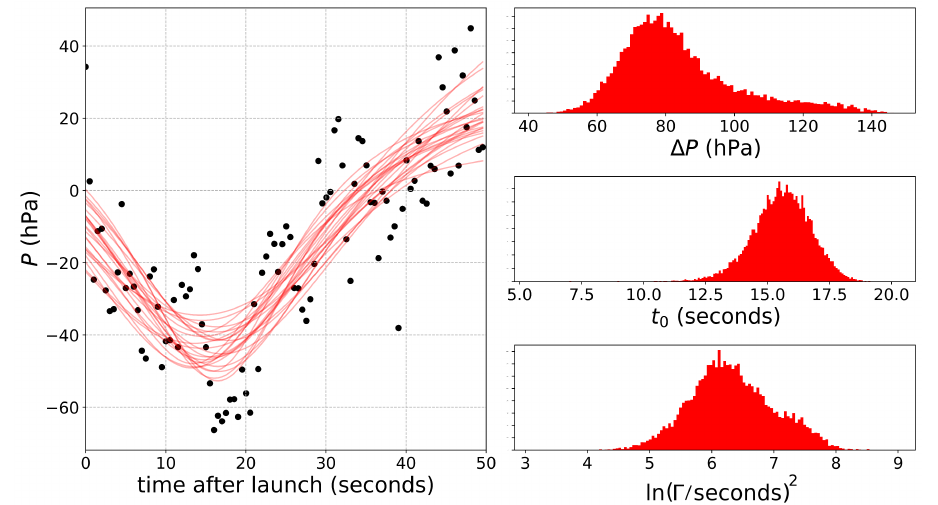
Figure 11. The left panel shows the Lorentz profile fit to first part of the pressure time-series from Flight 2. The right panels show the best-fit parameters for